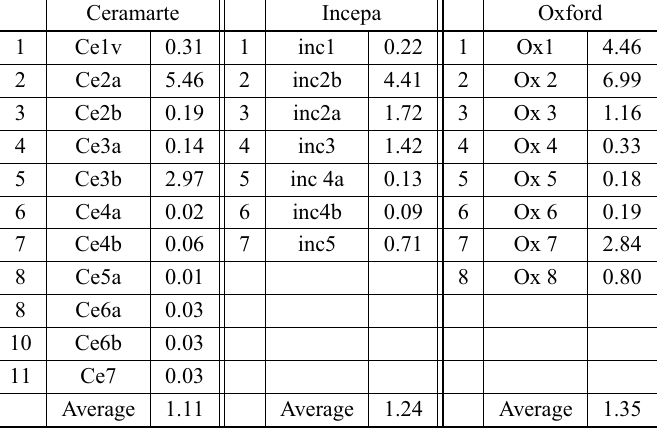
XRF analysis (wt. %) of K 2 O clay fractions of samples from